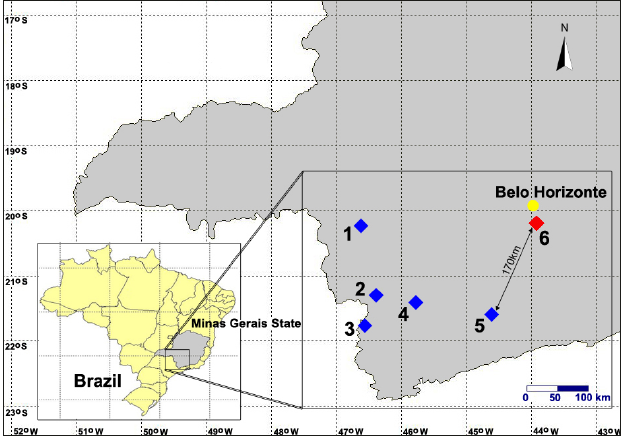
Figure 1. Geographic distribution